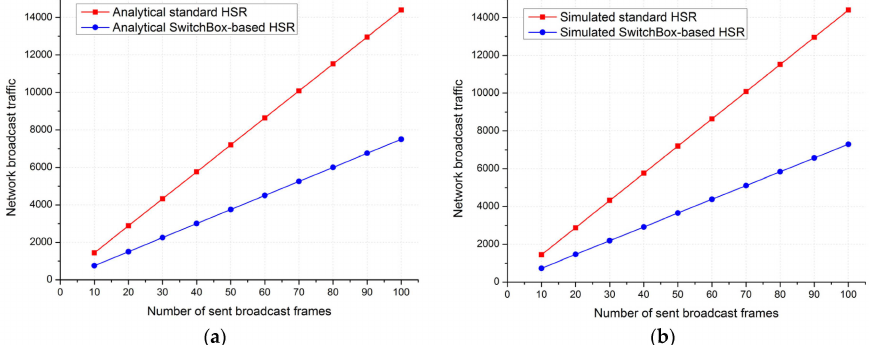
Figure 27. Comparison of the analytical and simulated broadcast traffic performance. ( a ) Analytical broadcast traffic; ( b ) Simulated broadcast traffic.